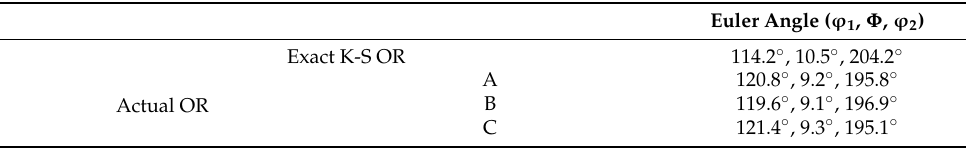
Figure 10. The relative density of grain boundaries. Table 3. Orientation relationships (OR) of these specimens.